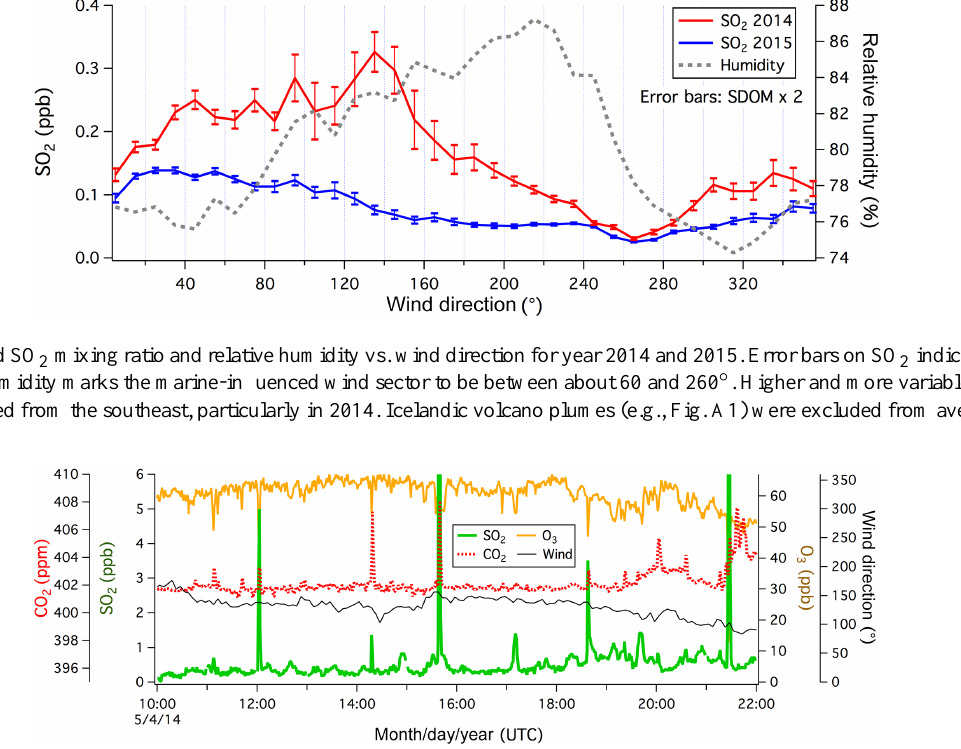
Figure 3. Example of local ship plumes on a day of southeasterly winds. Sharp peaks in SO 2 and CO 2 generally coincided with sudden depletions in O 3 (1min